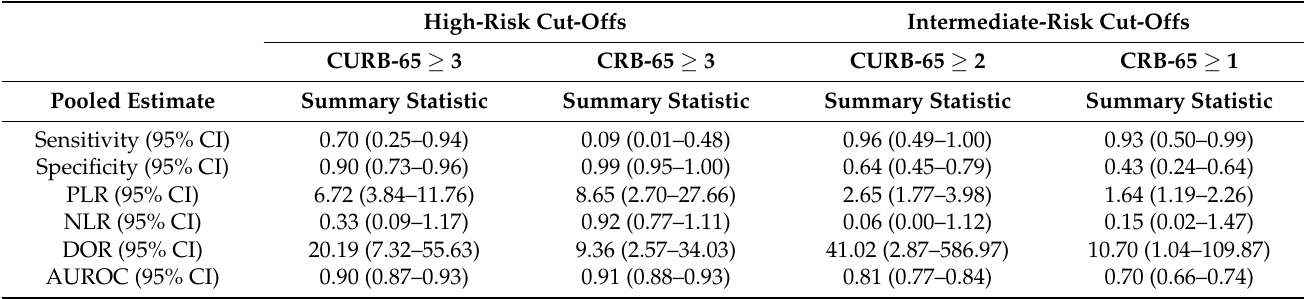
Table 2. Pooled performance characteristics of CURB-65 and CRB-65 for predicting mortality in high- and intermediate-risk cut-offs in community-acquired pneumonia